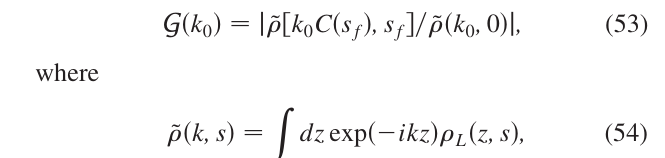
FIG. 15. First bunch compressor of FERMI@Elettra. The pa- rameters are listed in Table IV. The curve in blue is the reference curve in the laboratory system. The regions in gray represent the magnets.